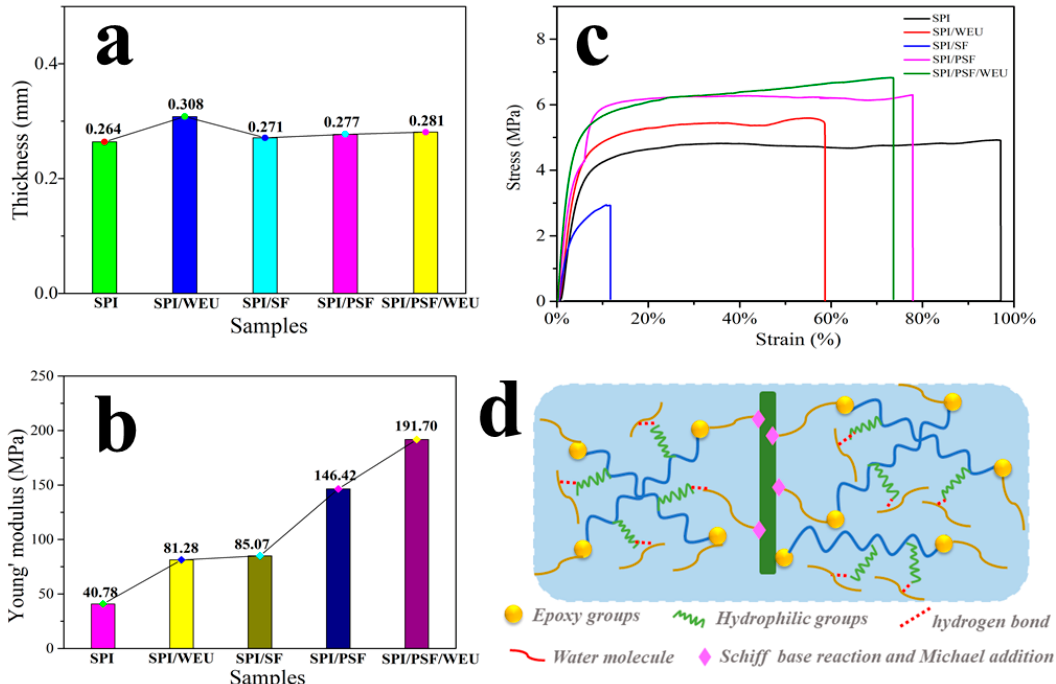
Figure 7. The thickness ( a ), Young’s modulus ( b ), stress–strain curves ( c ) of neat SPI, SPI/WEU, SPI/SF, SPI/PSF, and SPI/PSF/WEU films, and possible physical and chemical combinations in the films ( d